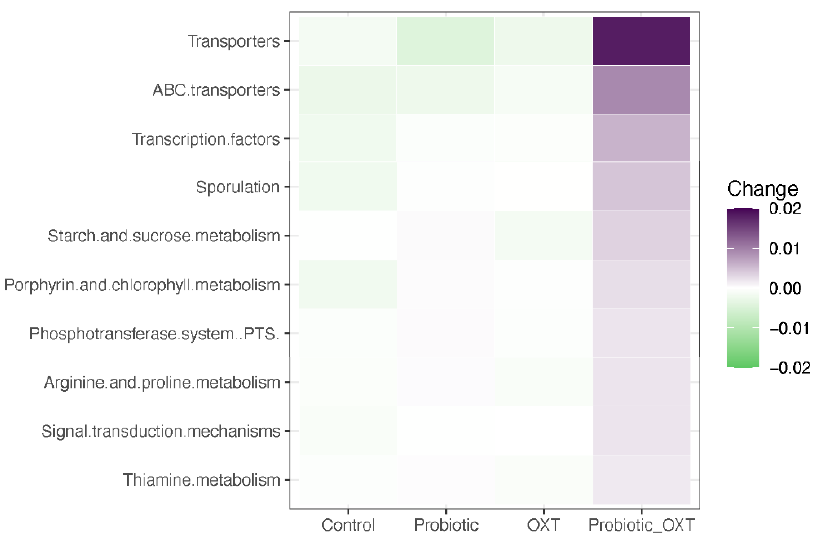
Figure 4. Heatmap of mean change in predicted functional profile based on gut microbiota abundance across four study groups. Shown changes in functional profiling indices demonstrated more changes in the combination group, although these changes are not significantly different when compared to the control group ( p > 0.05). Table 3. Spearman correlations between the microbiota relative abundance and socio-behavioral parameters before treatment for all subjects.